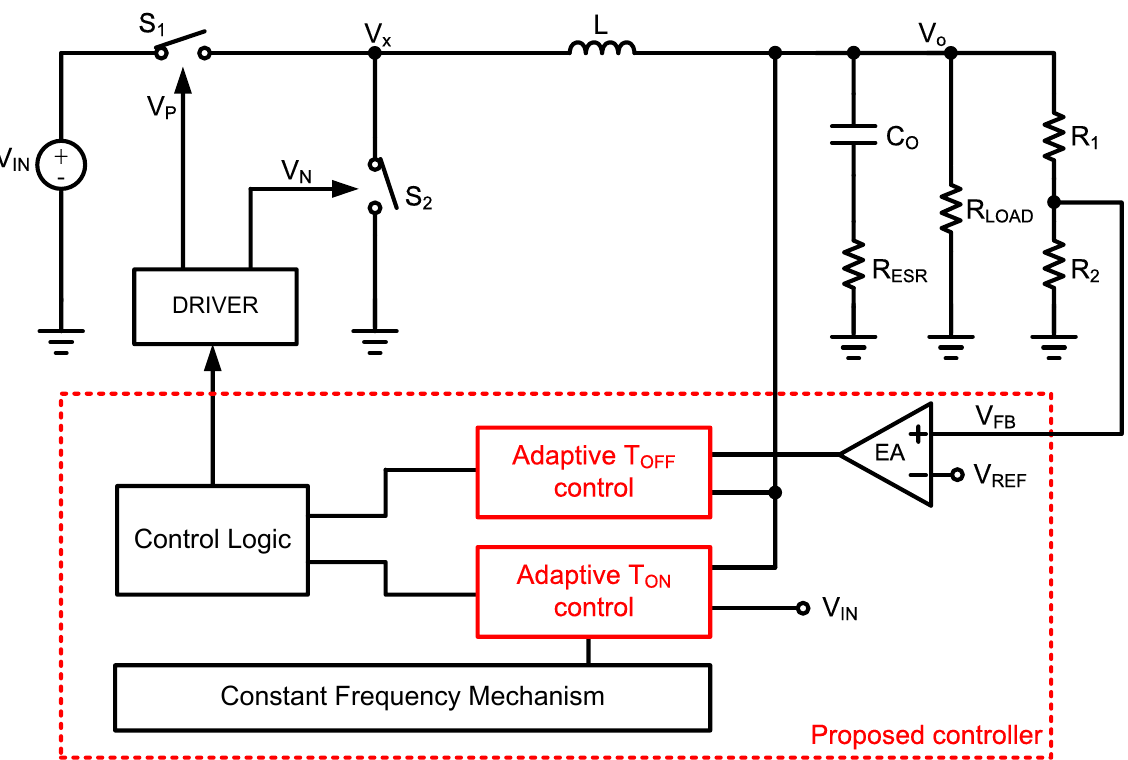
Figure 4. Proposed scheme.